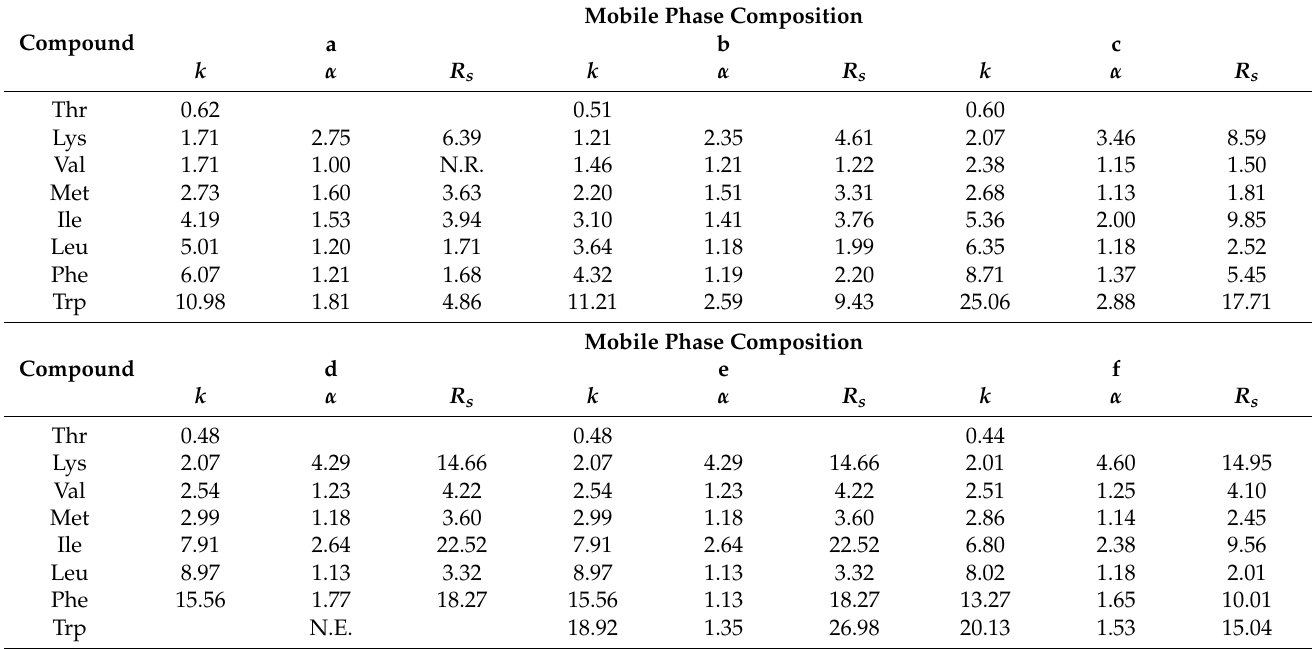
Table 1. Chromatographic performance obtained with the tested experimental conditions (see the footnote for details). k : Retention factor; α : separation factor; R S : resolution factor. All the analyses were followed at 220 nm. Separation ( α ) and resolution ( R S ) factor values are referred to two consecutive